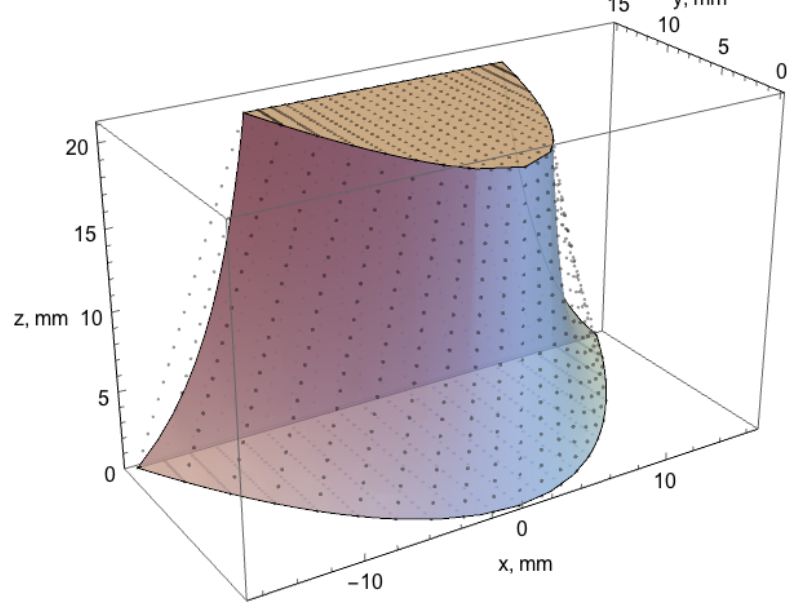
Figure 1. The blue surface shows the region defined by Equation (1) and the gray points are a linear interpolation between the two end